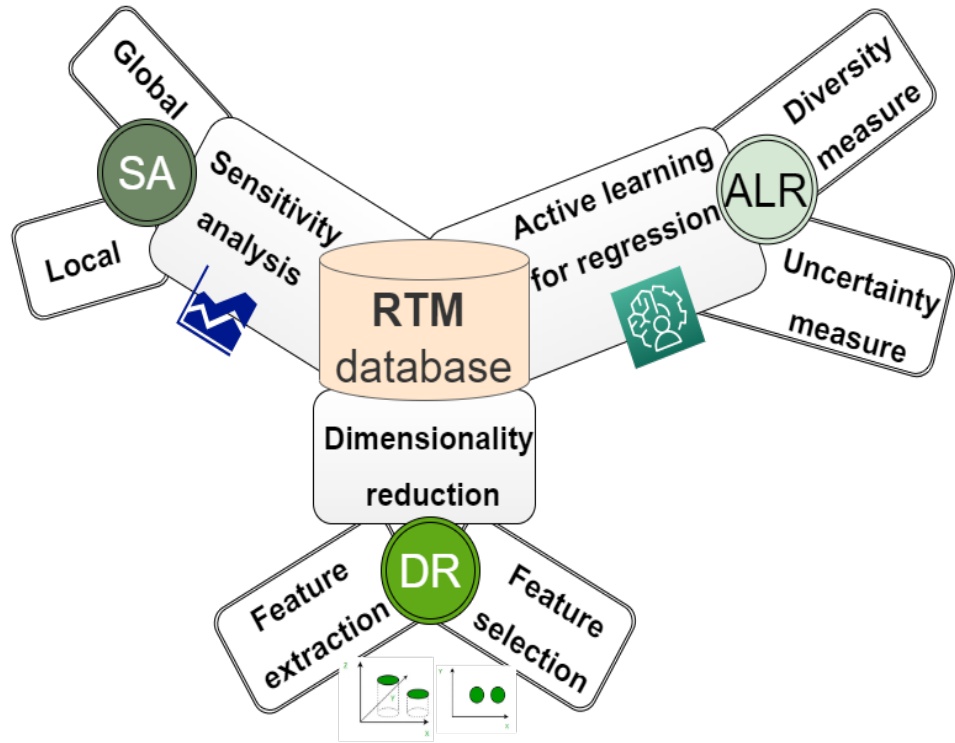
Figure 4. Overview of the techniques used in simulating the